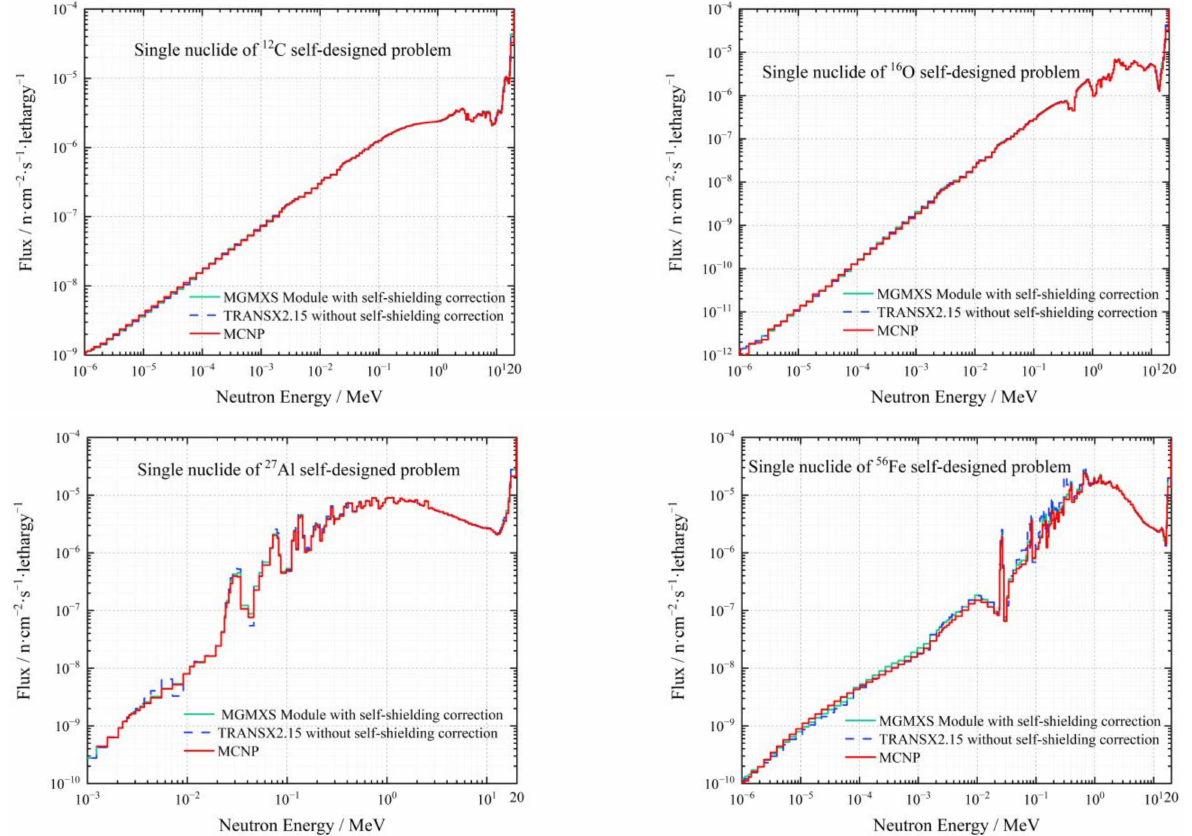
Figure 8. Comparison of self-designed problems without self-shielding corrections.